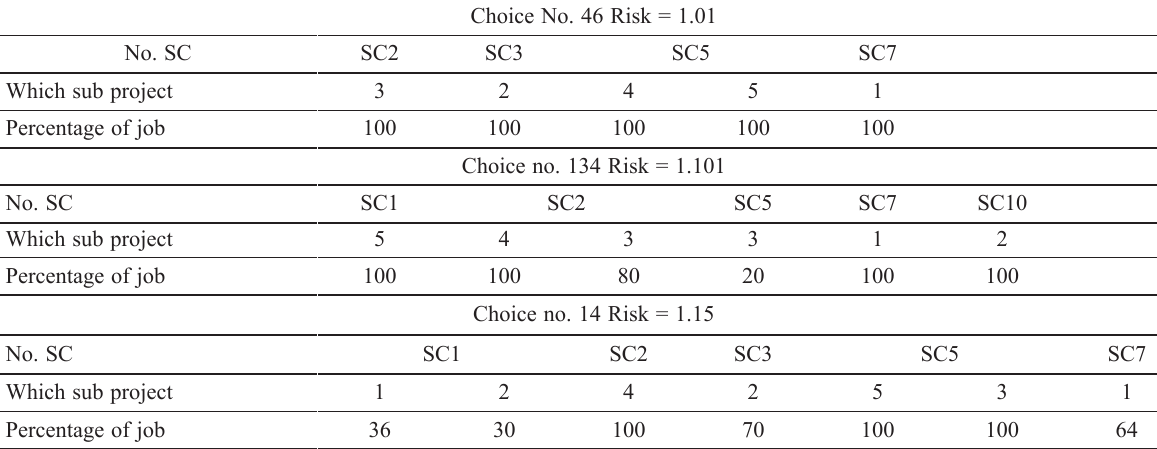
Table 6. Portfolios’ characteristics for ETC = 23